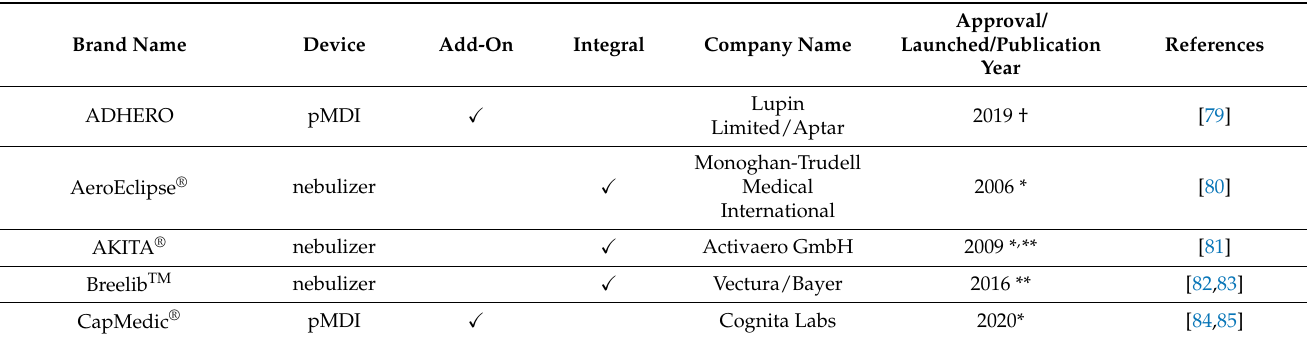
Table 1. Marketed and under-development digitalized nebulizers, pMDIs, and SMIs in alphabetical order (not intended to be fully